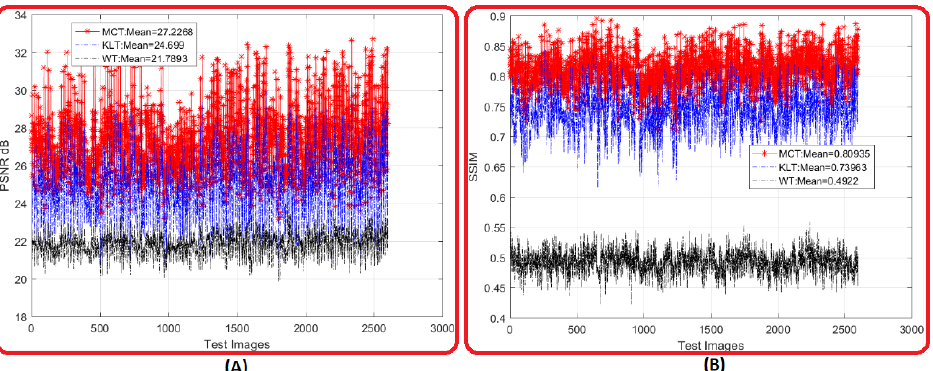
Figure 13. A metric comparative evaluation applied on 2600 facial images of warp face dataset of AR database. ( A ) PSNR and ( B )